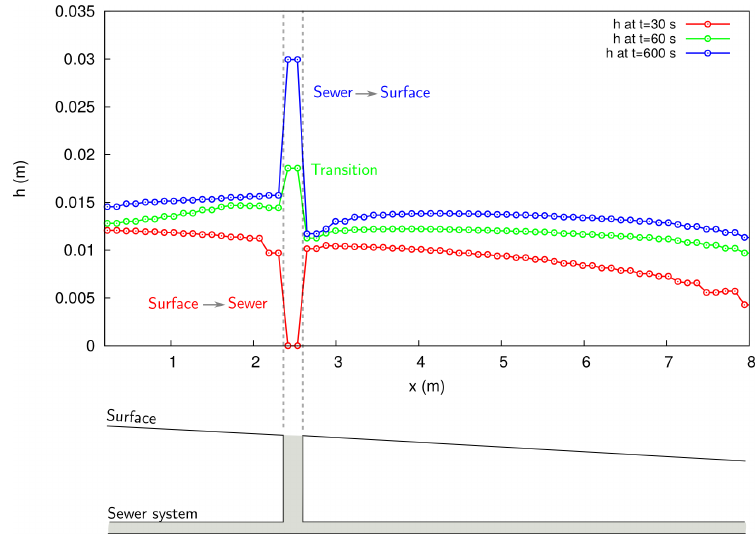
Figure 7. Profile view of the numerical results corresponding to three different times. Note the sign change of the exchange flow.